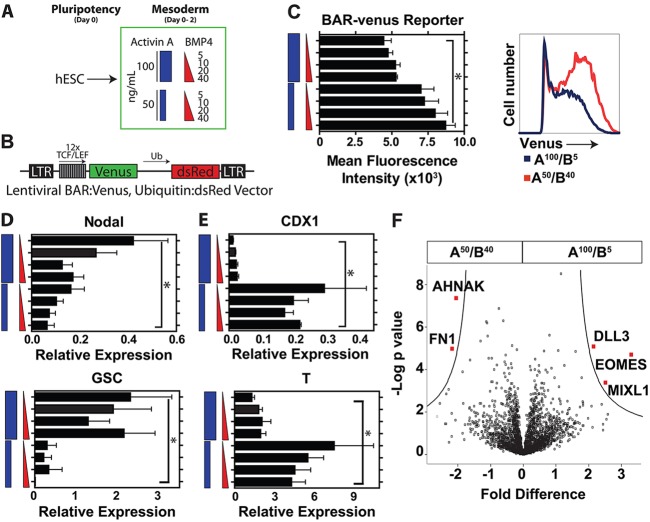
Directing mesoderm patterning by titrating activin A and BMP4. (A) The experimental approach for directing undifferentiated hESCs into anterior versus posterior mesoderm using doses of activin A and BMP4. (B) The BAR-Venus:Ub-dsRed vector used to measure endogenous Wnt/β-catenin signaling in differentiating hESCs. (C) Changes in mean fluorescence intensity of BAR-Venus activity on day 2 of directed differentiation under different activin A/BMP4 conditions (left), and a representative flow plot showing reporter activity in conditions of 100 ng/ml activin A and 5 ng/ml BMP4 (A100/B5) versus 50 ng/ml activin A and 40 ng/ml BMP4 (A50/B40) (right). (D,E) qRT-PCR analysis of genes involved in mesoderm patterning, including anterior mesoderm markers NODAL and GSC (D) as well as posterior markers CDX1 and brachyury (T) (E). n=5 biological replicates for BAR-Venus activity and qPCR analysis. *P<0.05. (F) Volcano plot showing proteins significantly differentially expressed between day 2 A50/B40 and A100/B5 cells using an FDR threshold of 0.05. For mass spectrometry n=2 biological replicates, each with three technical replicates per sample.